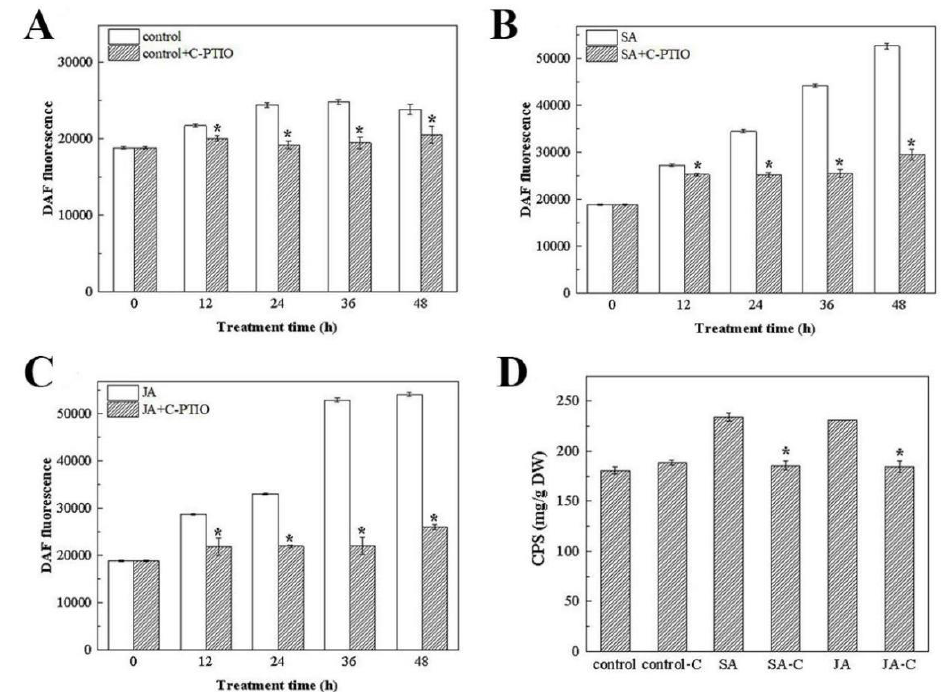
Figure 5. Effect of the C-PTIO on the NO content ( A – C ) and polysaccharide production ( D ) in N. flagelliforme under salicylic acid and jasmonic acid. ( A ) * p < 0.05, compared with the control group, ( B ) * p < 0.05, compared with the SA group, ( C ) * p < 0.05, compared with the JA group, and ( D ) * p < 0.05, compared with the SA and JA group.